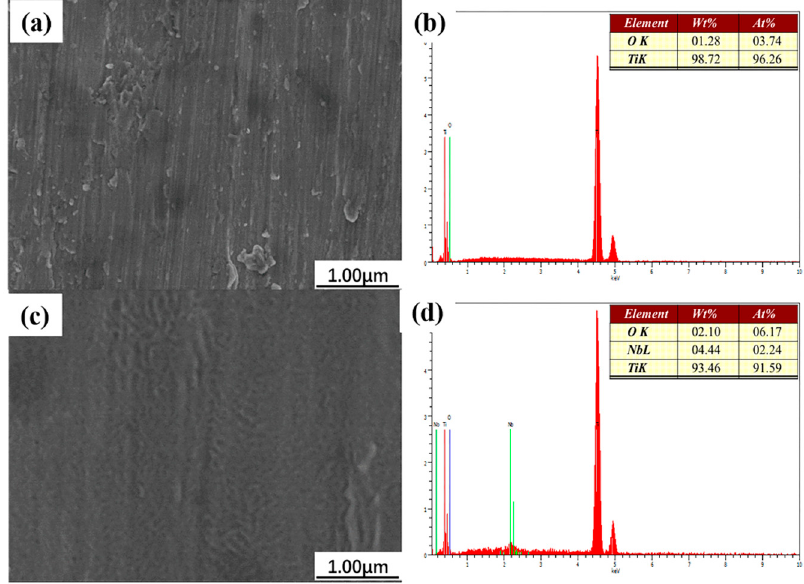
Figure 1. Backscattered SEM images and EDS analysis: ( a , b ) substrate, ( c , d ) Nb-implanted sample.